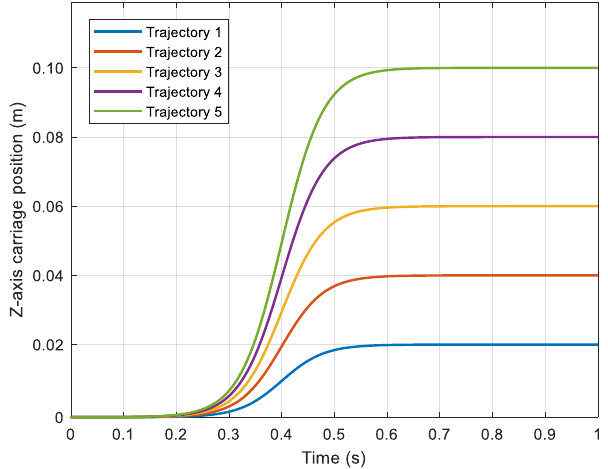
Figure 10. Set paths of the carriage.